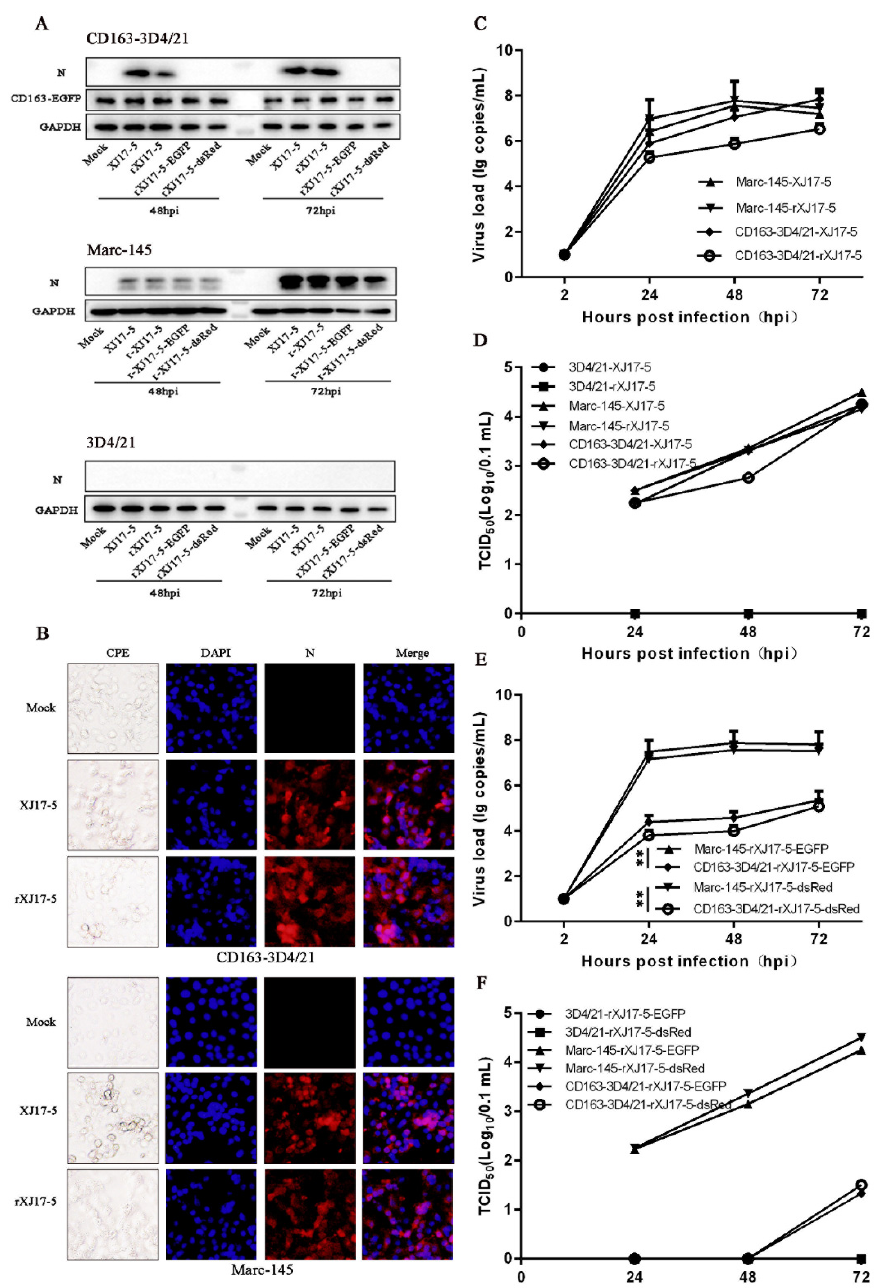
Figure 1. Growth of HP-PRRSV2 virulent strain XJ17-5 (lineage 8) on 3D4/21 cells stably expressing porcine CD163. ( A ) The CD163-3D4/21 cells, MARC-145 cells, and 3D4/21 cells seeded in 24-well plates were infected with PRRSV XJ17-5 and infectious cDNA clones (rXJ17-5, rXJ17-5-EGFP, or rXJ17-5-dsRed) at an MOI of 0.1, for 48, and 72 h, respectively, followed by Western blotting. ( B ) CD163-3D4/21 cells and MARC-145 cells were infected with PRRSV XJ17-5 and rXJ17-5 at an MOI of 0.1, respectively. The infected cells were observed for CPE and fixed at 48 h post infection (hpi) followed by immunofluorescence assay (IFA): PRRSV N protein specific mouse mAb (15A1, 1:500) was used as the primary antibody, and the DyLight™ 594 (Goat anti-mouse IgG, 1:800, Invitrogen) was used as the secondary antibody. ( C – F ) Replication of PRRSV XJ17-5 and infectious cDNA clones (rXJ17-5, rXJ17-5-EGFP, or rXJ17-5-dsRed) in CD163-3D4/21 cells, MARC-145 cells, or 3D4/21 cells. The ORF7 transcriptions and virus titers of PRRSV XJ17-5 and infectious cDNA clones of XJ17-5 within 72 hpi were determined by SYBR Green real-time RT-PCR assay ( C , E ) and TCID50 ( D , F ), respectively. ** p < 0.01.